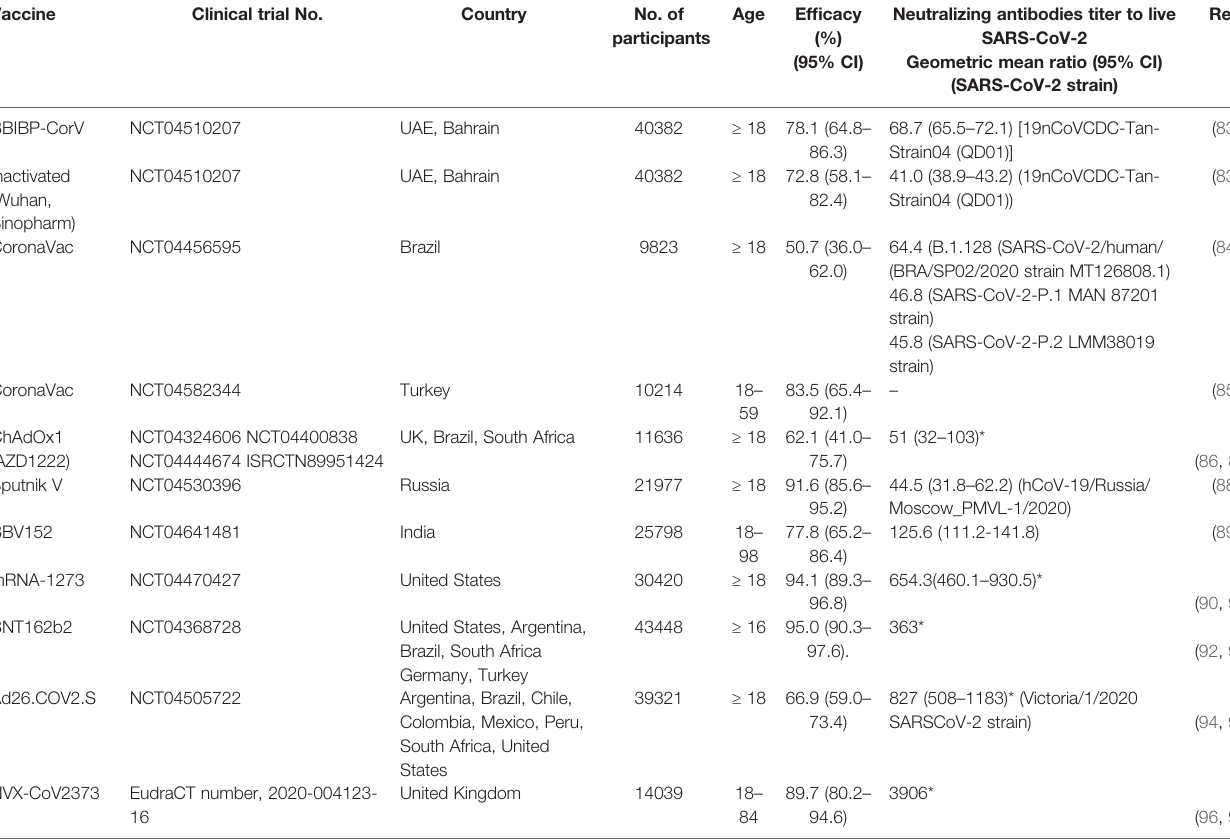
*Represents that these data were reported in phase I or II clinical